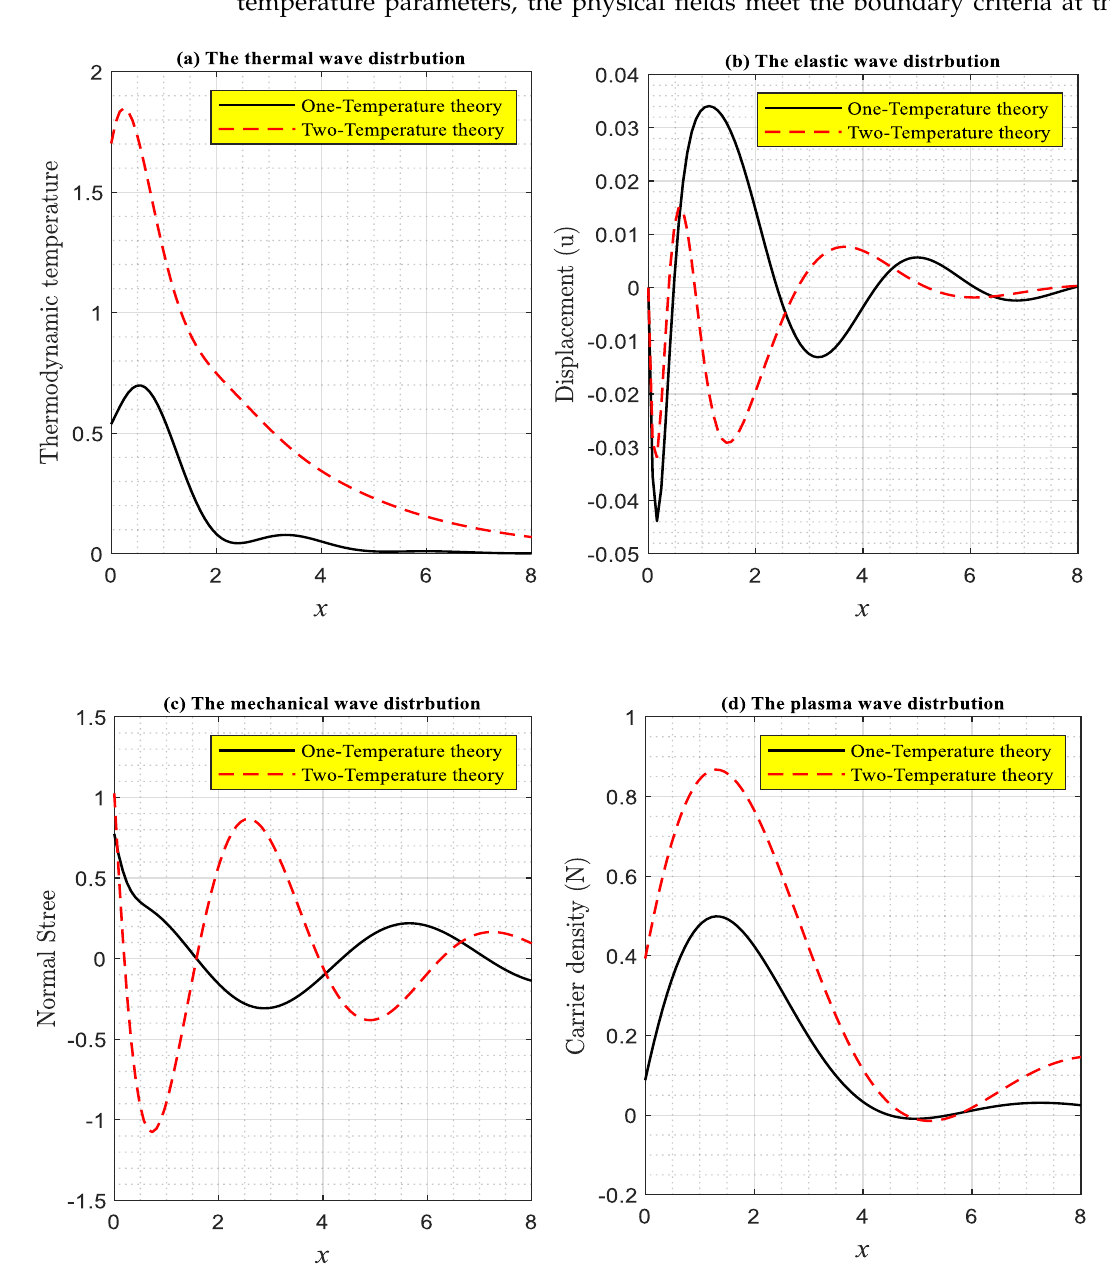
Figure 4. The main field distributions in distinct two-temperature cases under the influence of laser pulses vary with horizontal distance in accordance with the DPL